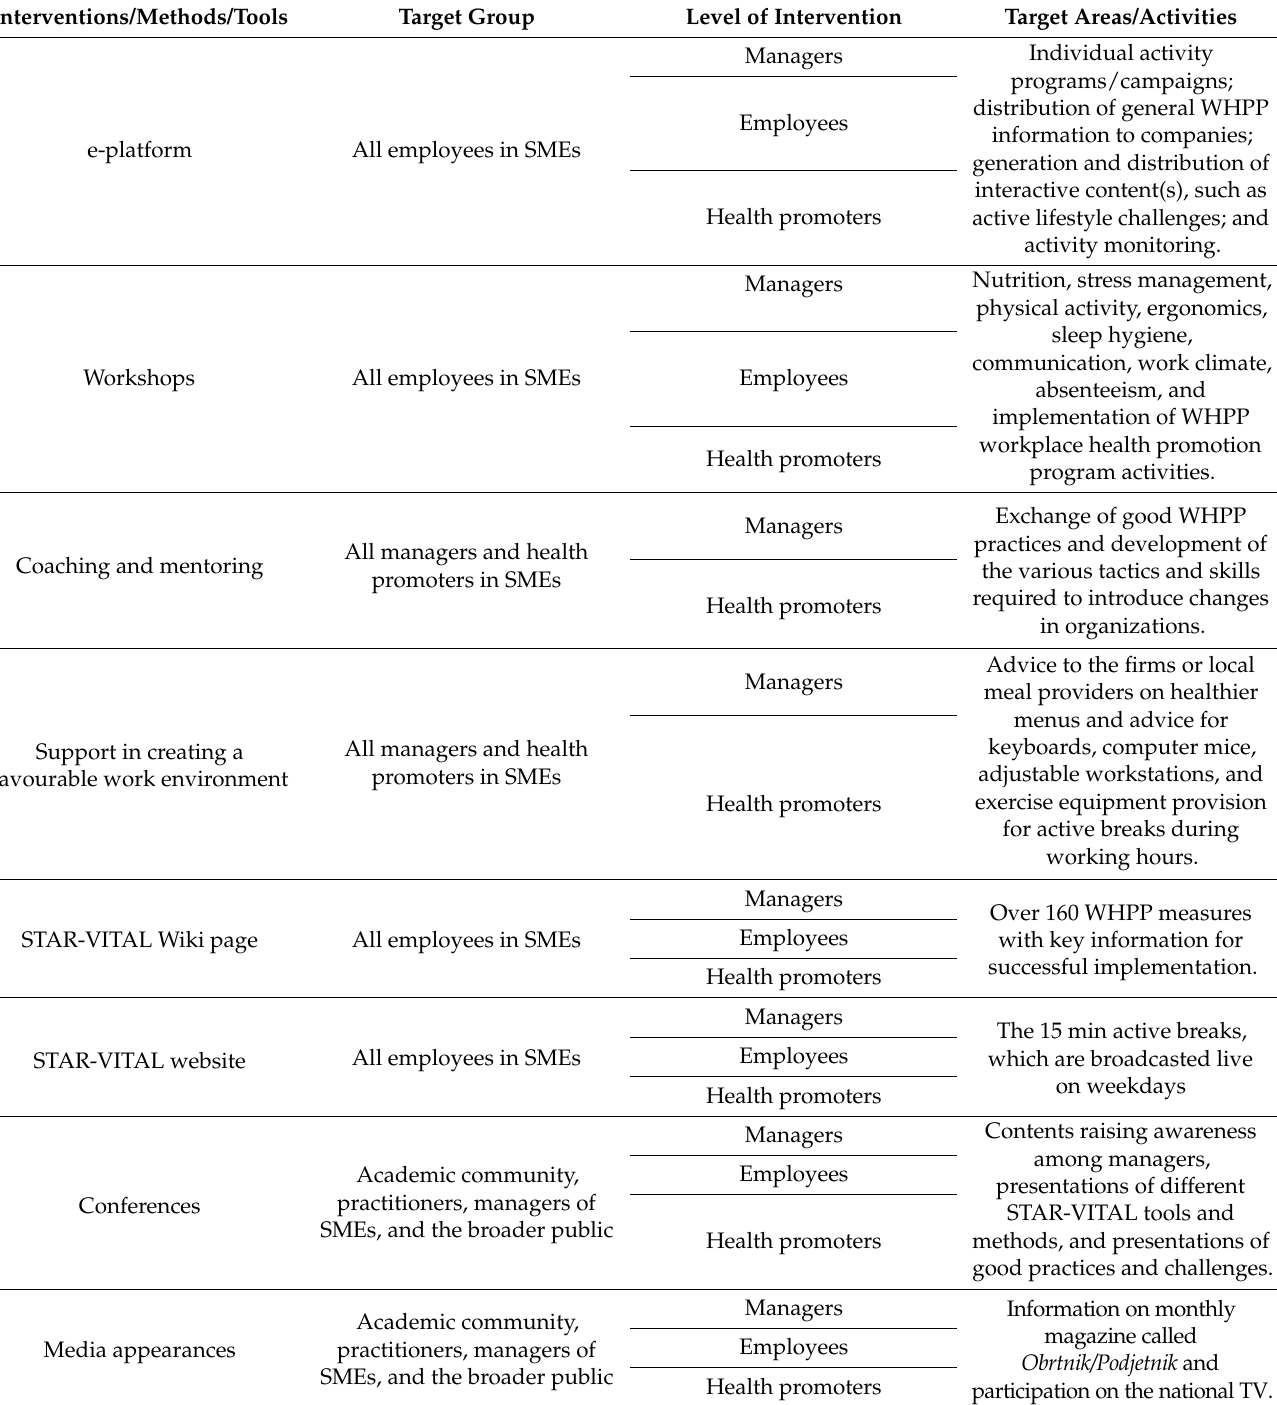
Table 1. Projects interventions and